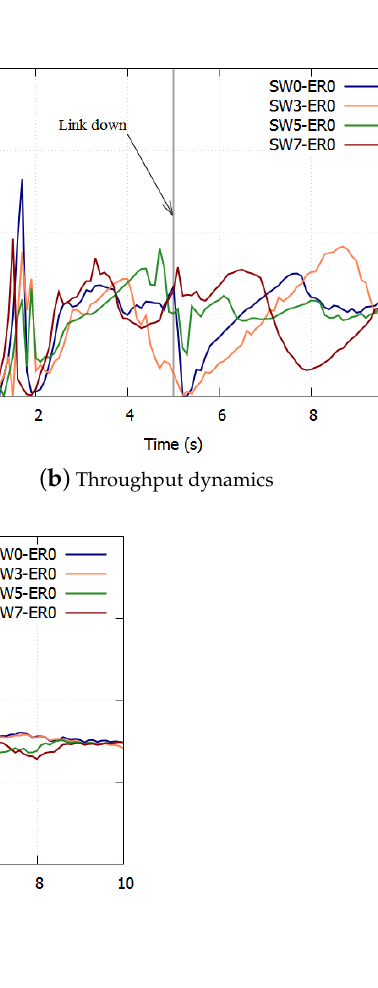
Figure 8. Result with the proposed